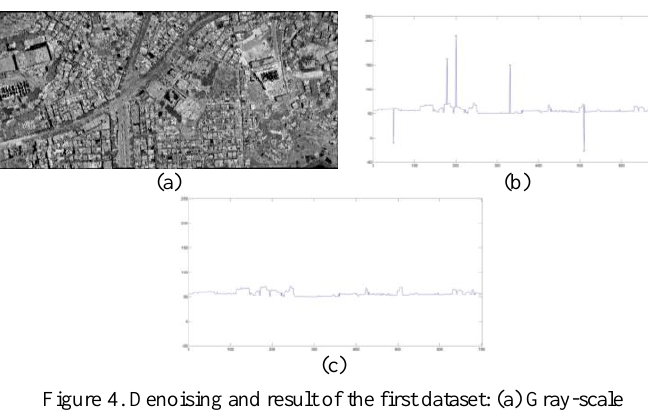
Figure 4. Denoising and result of the first dataset: (a) Gray-scale image rendered using intensity values; (b) A horizontal profile of the DSM (red crossed symbols indicate outliers); and (c) The corresponding result after denoising.